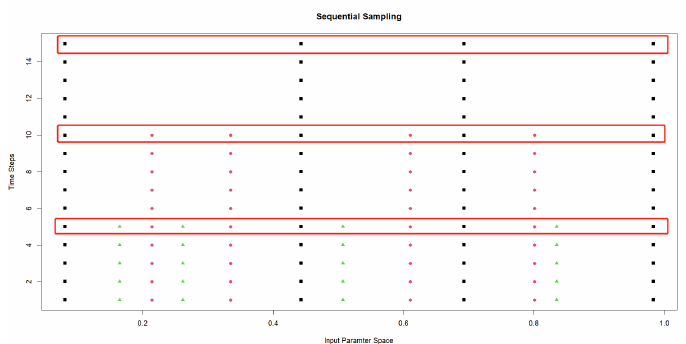
Figure 1. An illustration of the reverse sequential sampling